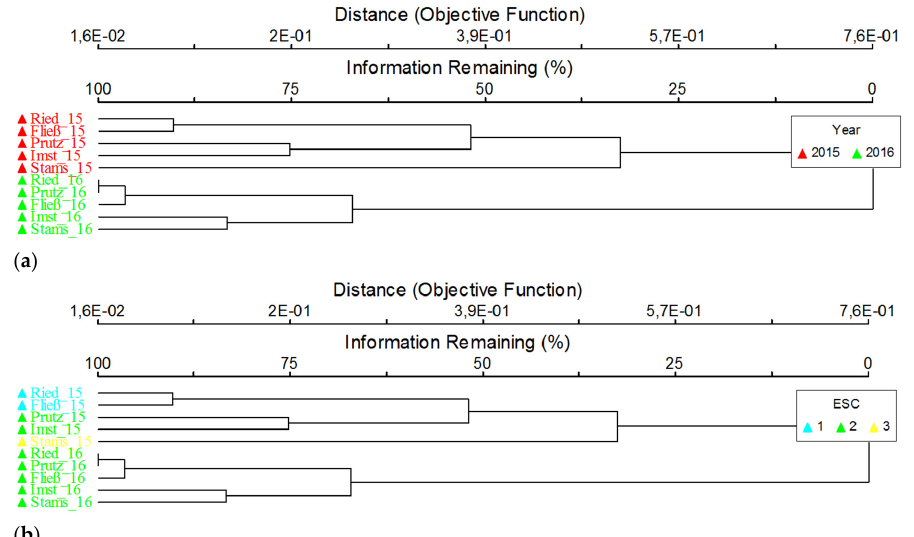
Figure 6. Cluster analyses; dendrogram; all sites (annex to site labels: 15 = 2015, 16 = 2016), both sampling dates; overlays; ( a ) sampling date (year: 2015 = November 2015, 2016 = March 2016); ( b ) ecological status class (ESC; status; 1 = high, 2 = good, 3 = moderate).